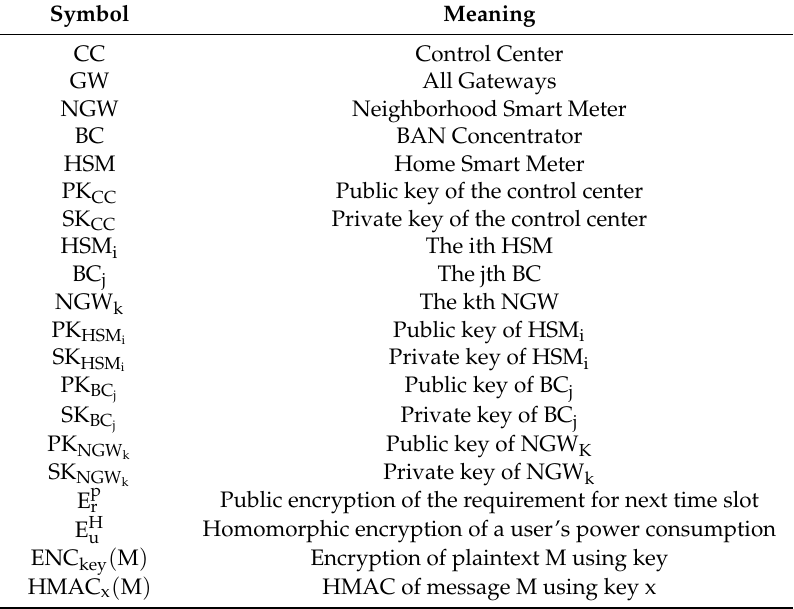
Table 1. Notations used in EPPRD.